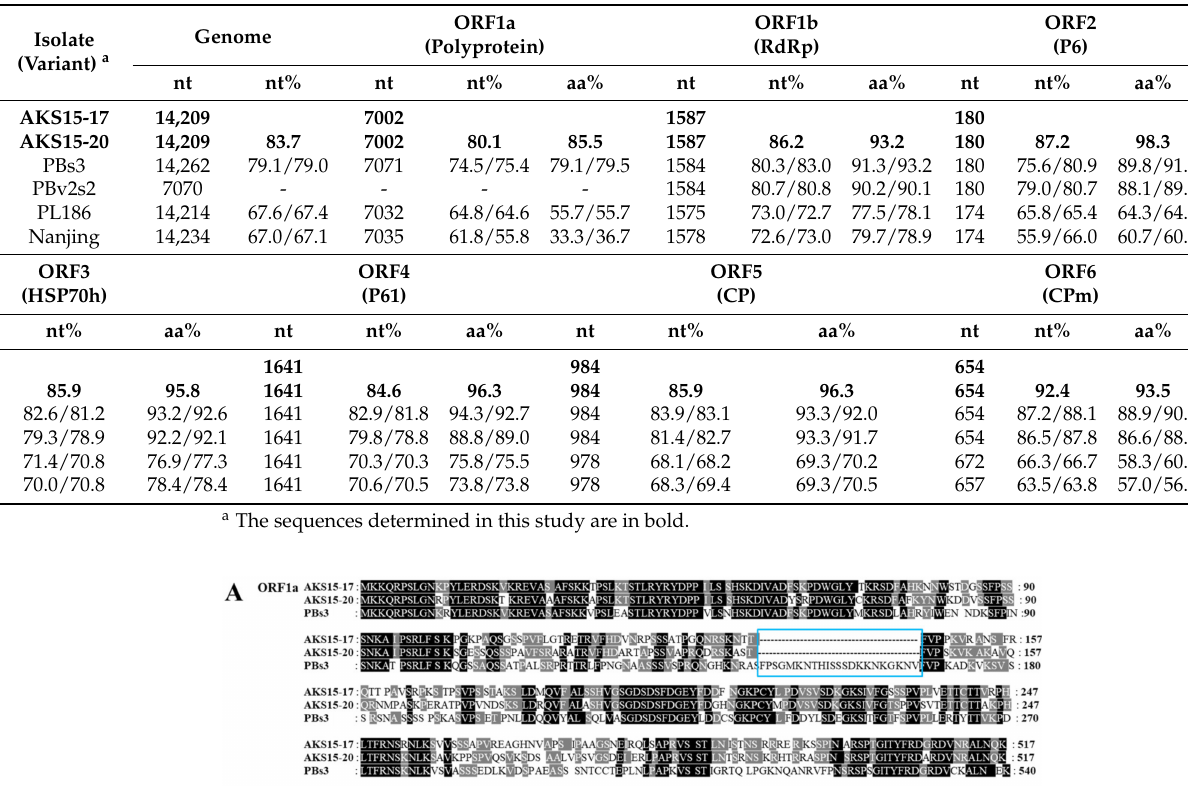
Table 2. Genome sequence comparison of PAmpV-Ju variants AKS15-17 and AKS15-20 infecting a jujube plant AKS15 with PAmpV isolates PBs3 and PBv2s2, and PBNSPaV isolates PL186 and Nanjing.